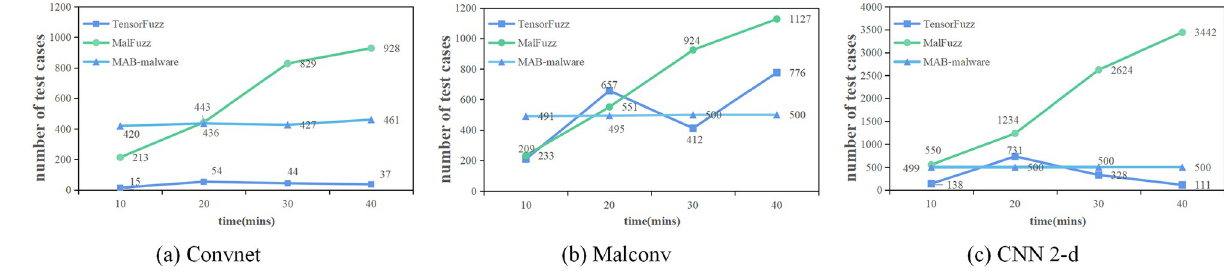
Fig 5. Number of test cases generated in 10,20,30,40